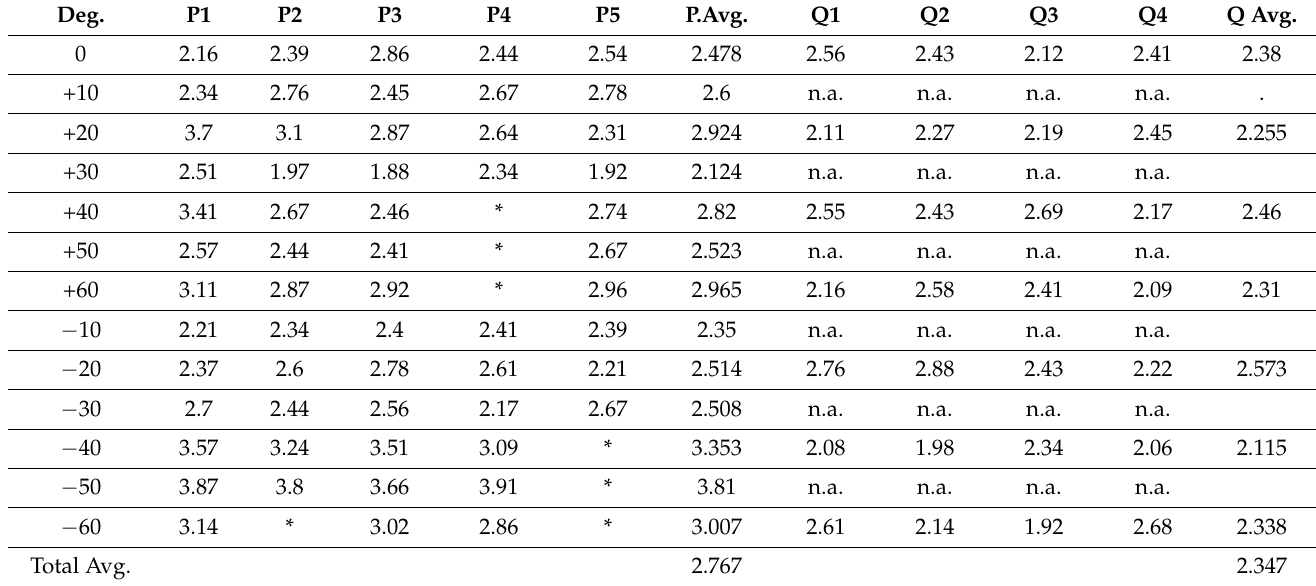
Table 4. Deviations from markers on head phantoms in mm with masked observer and dim